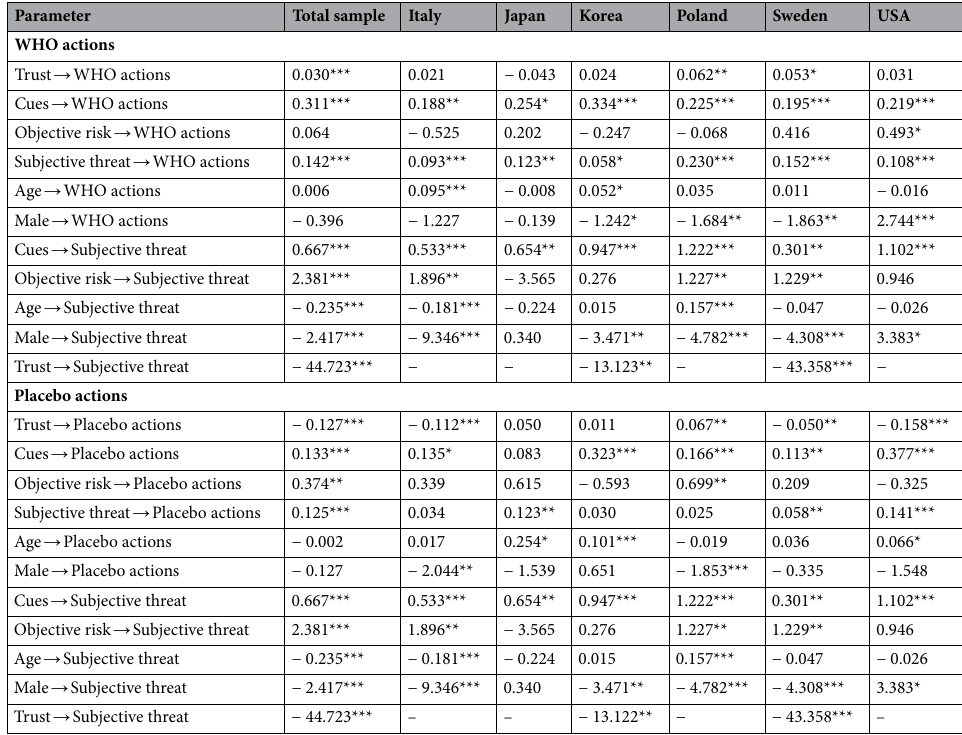
Table 3. Results of the path analyses—unstandardized coefficients. *p < 0.05. **p < 0.01. ***p < 0.001; Total sample: N = 3346; Italy: N = 405, Japan: N = 190, Republic of Korea: N = 551, Poland : N = 1092, Sweden: N = 587, USA: N = 521; WHO actions: R 2 = 0.23 for the total sample, R 2 = 0.14 for Italy, R 2 = 0.14 for Japan, R 2 = 0.21 for Korea, R 2 = 0.32 for Poland, R 2 = 0.17 for Sweden, R 2 = 0.25 for the USA; Placebo actions: R 2 = 0.13 for the total sample, R 2 = 0.11 for Italy, R 2 = 0.08 for Japan, R 2 = 0.13 for Korea, R 2 = 0.08 for Poland, R 2 = 0.11 for Sweden, R 2 = 0.21 for the